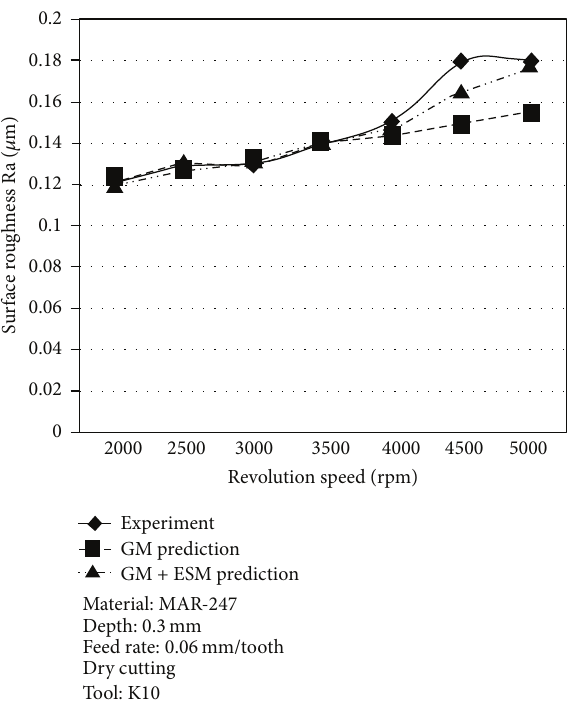
Figure 13: Relationships between revolutions.